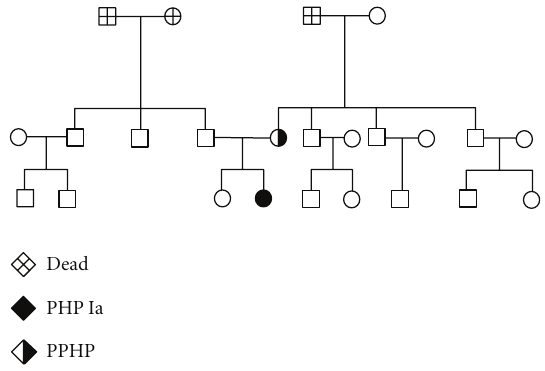
Figure 3: Family tree of the